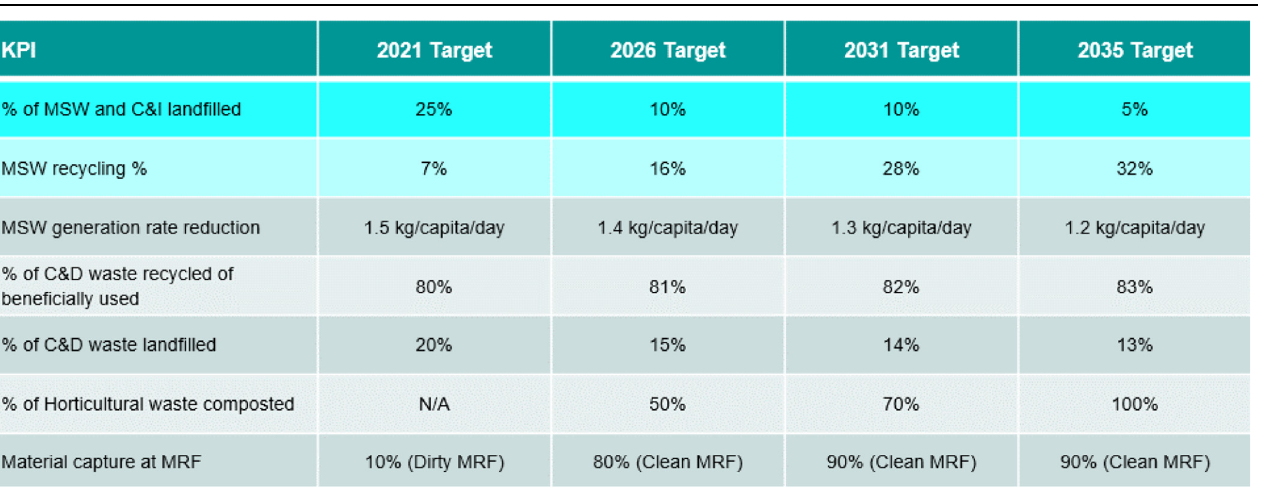
Table 4. Forecast of the waste management key performance positions